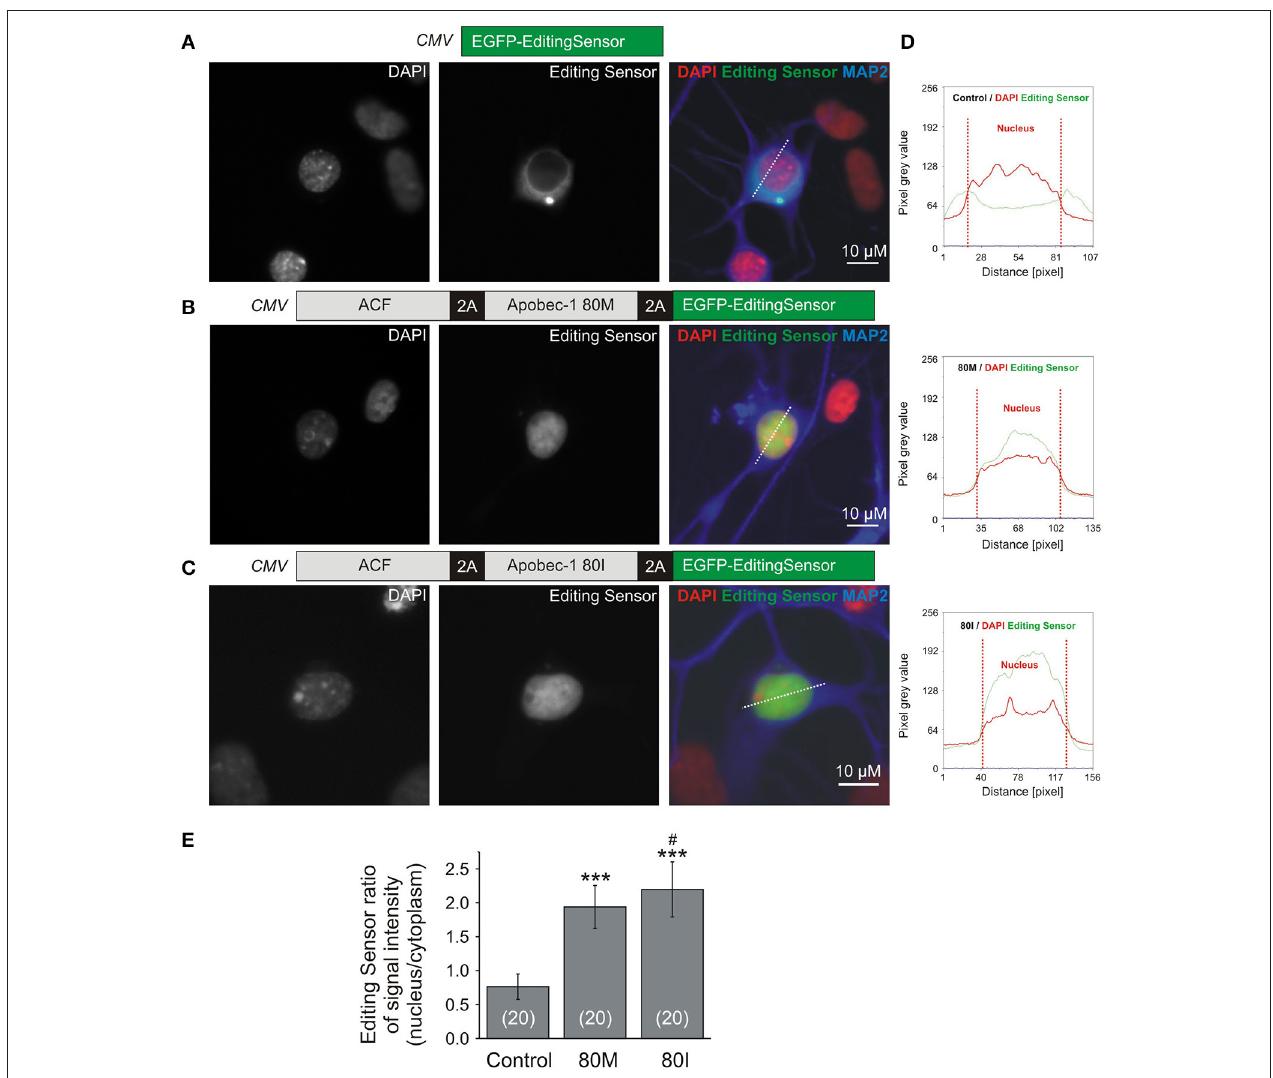
FIGURE 4 | Primary rat hippocampal (RHC) neurons were used to evaluate the functionality of the RNA editing sensor. (A–C) Representative images of RHC neurons transfected with the constructs shown in Figure 2B . Images show fluorescence corresponding to DAPI (left panels), sensor signals (middle panels), and merged signals including MAP2-stain shown in blue (right panels) without ( A , control, editing sensor alone) or with Apobec-1 80M ( B , 80M) or Apobec-1 80I ( C , 80I) co-expression. Dotted lines show examples of the placement of line-scans quantified in (E) . (D) Examples of line scans of pixel intensities of the editing sensor (green) and DAPI (red) through cytosol and nucleus in the three different conditions. The dotted red vertical lines delineate the nuclear region (“Nucleus”). (E) Quantification of the fluorescence ratios between nucleus and cytosol in line-scanned specimen. All data are given as mean ± SD. Asterisks mark significant differences between editing sensor alone and with 80M or 80I. The “#” symbol indicates a significant difference ( P = 0.034) between 80M and 80I while *** mark significant differences between control and 80M or 80I ( P < 0.001), as assessed using one-way Anova followed by post-hoc Tukey test. The number of analyzed cells is indicated in